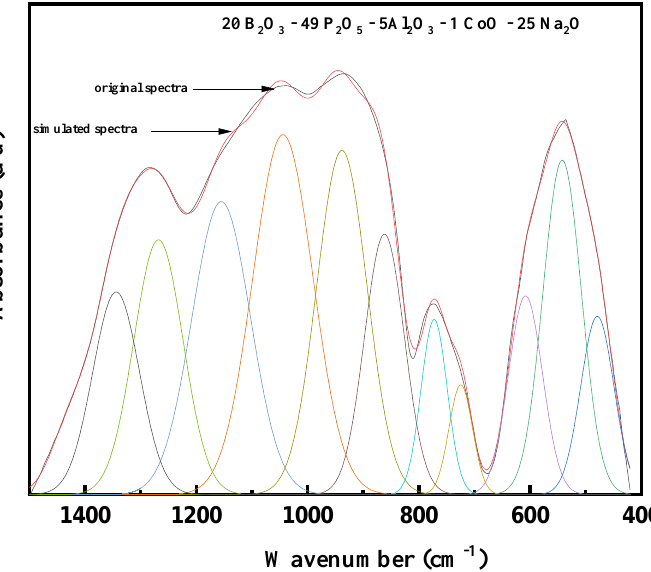
Figure 4. Curve fitting of FTIR spectra of the glasses 49P 2 O 5 –20B 2 O 3 –5Al 2 O 3 –25Na 2 O–1CoO.